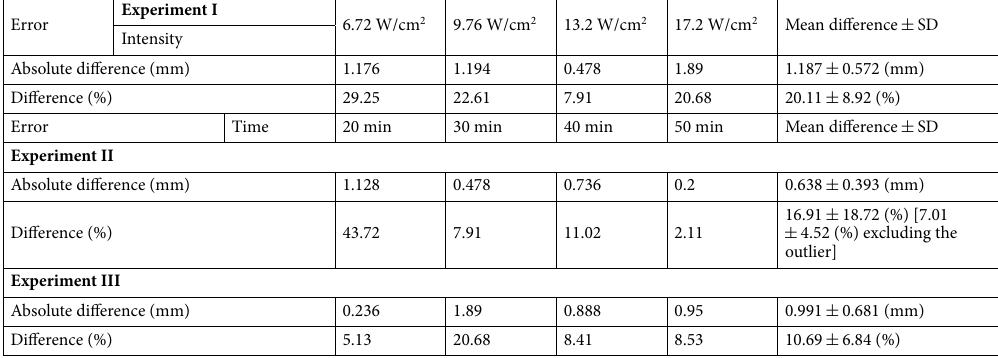
Table 2. This table shows the errors of numerical penetration depths compared to each experiment. The first three rows are data related to Experiment I, and others are error data for Experiment II and Experiment III. The relative differences, with experimental data as the reference, are listed as